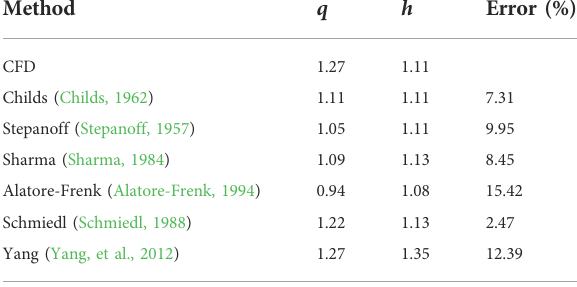
TABLE 7 CAU-280-01 performance prediction data and errors.